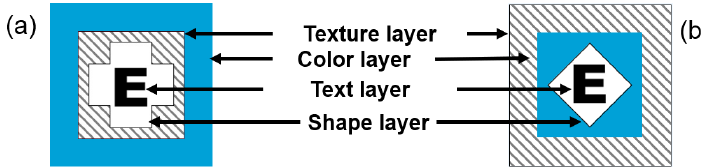
Figure 3. Layered glyph’s design. ( a )—A glyph with the visual variables: color, texture, shape, and text; ( b )—In this glyph, color and texture were exchanged compared to ( a